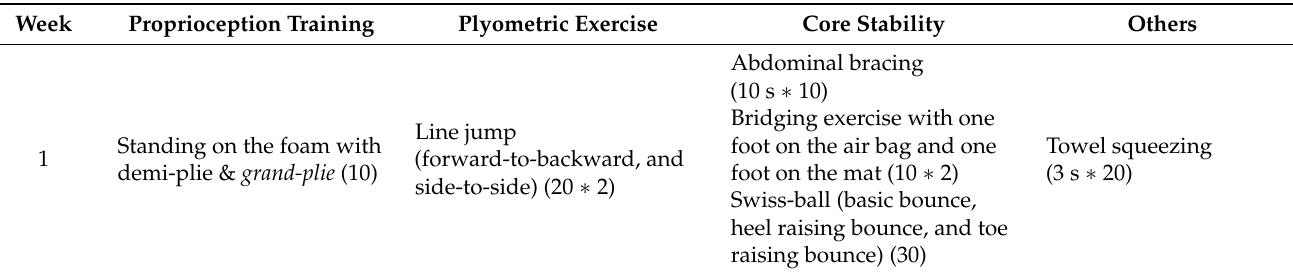
Table 1. Exercise Table 1. Exercise program. Table 1. Exercise program.